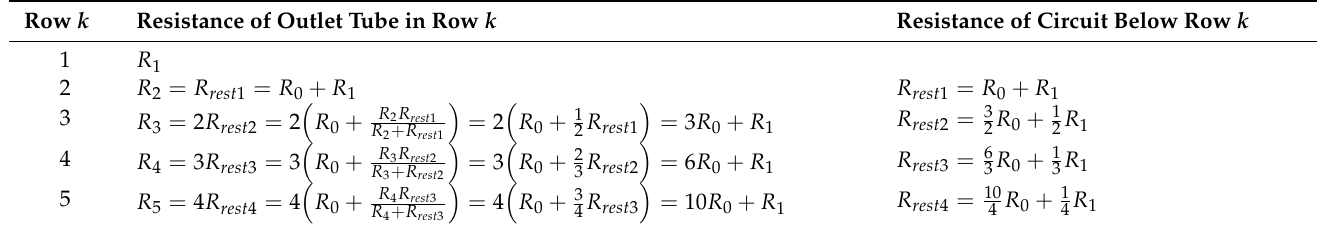
Table 1. Equations to calculate the outlet tube resistances as a function of the connecting resistance R 0 and the bottom outlet resistance R 1 . Only the equations for the lowest outlet tubes are shown in the table. The general equation for the outlet resistance of row k is presented in the text (Equation (4)). R rest ( k − 1 ) is the flow resistance of the circuit below row k